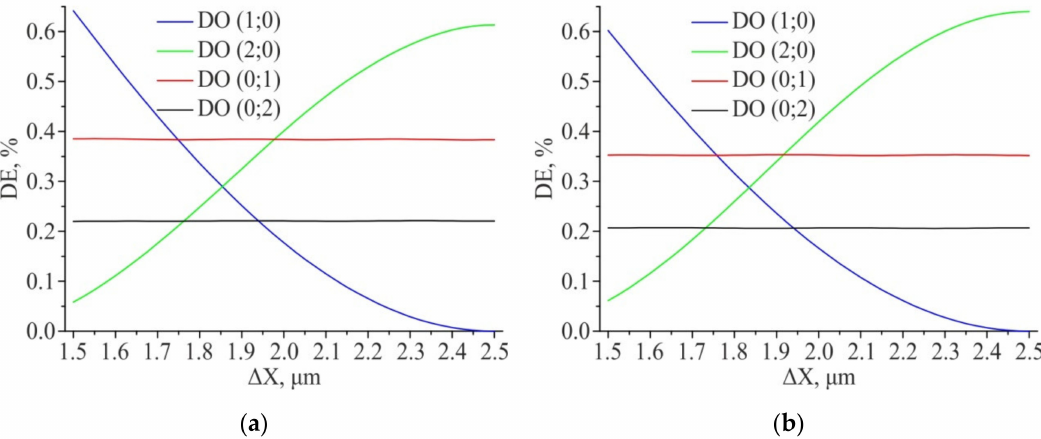
Figure 12. Results of modeling the diffraction efficiency for amplitude 2D DSE ( ∆ Y = const = 1.75 µ m): “Positive” structure ( a ); “Negative” structure ( b ). Feature size—1.5 µ m × 1.5 µ